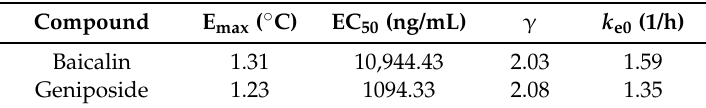
from MTG change of MTG rats during 2.5 h after QKLI administration.